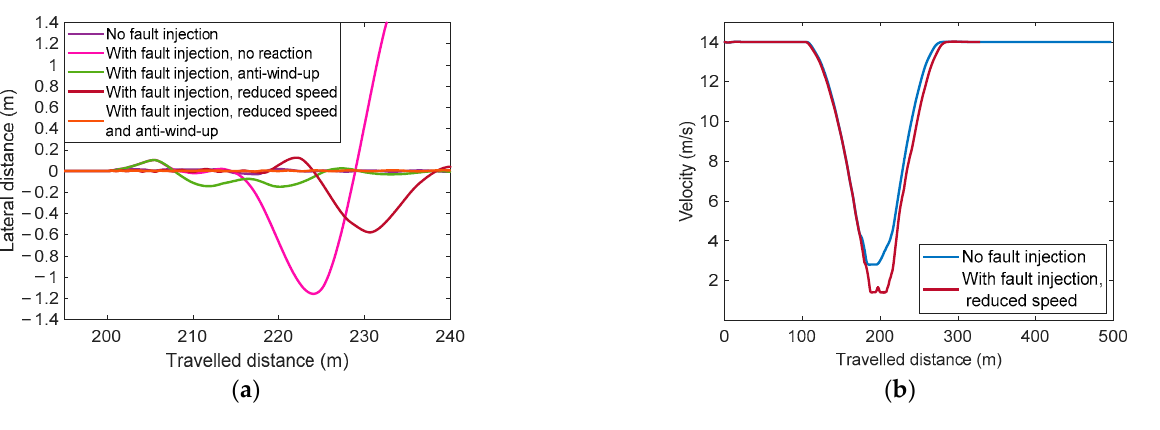
Figure 8. Lateral distance to the reference curve for the different fault injection cases ( a ) and planned vehicle velocity with and without reduced speed as a reaction to the injected fault ( b ).